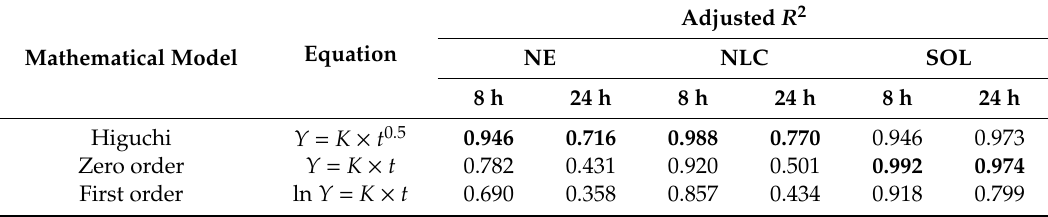
Table 5. Adjustment of the mathematical model to the release profile of O. sanctum ethanolic extract in nanoemulsion (NE), nanostructured lipid carriers (NLC), and solution (SOL).